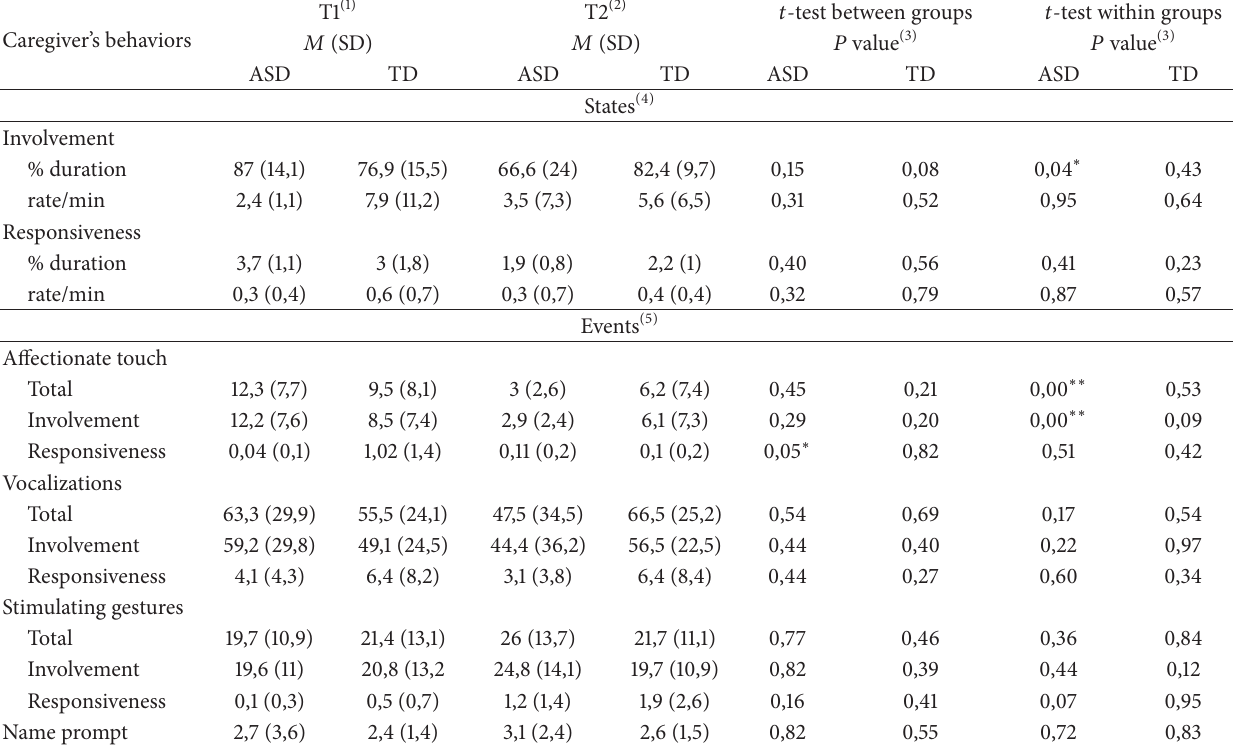
Table 3: Caregiver’s behaviors: means and standard deviations for ASD and TD. 𝑡 -test between groups at T1 and T2 and within groups in ASD and TD.